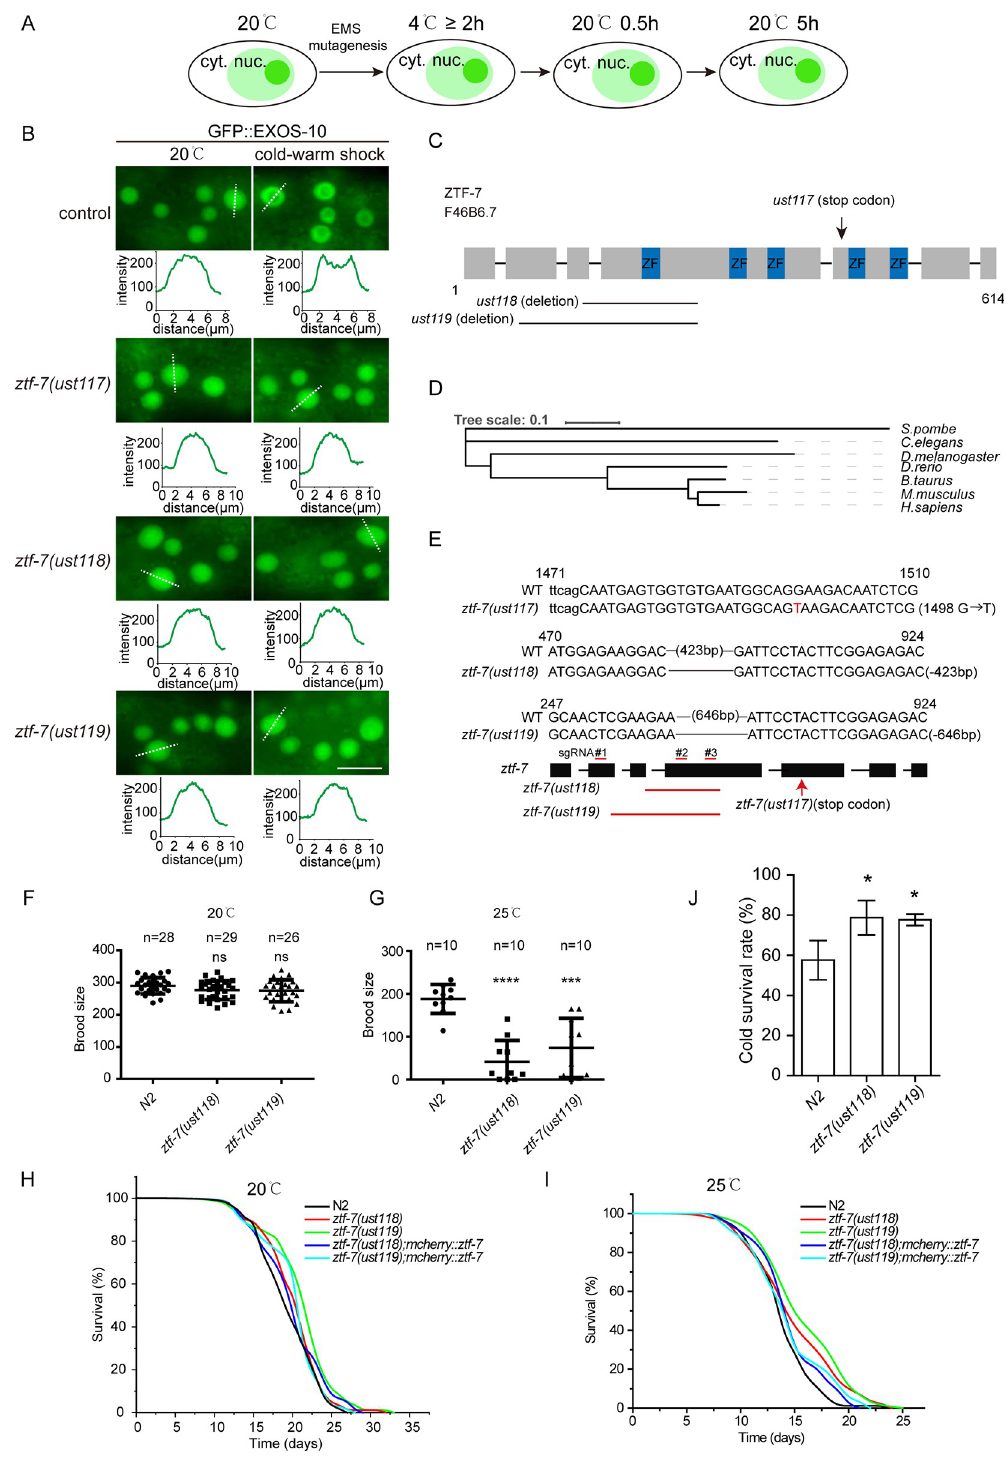
Fig 3. ZTF-7 is required for the cold-warm shock-induced nucleolar depletion of the RNA exosome complex. (A) Schematic showing forward genetic screening to search for factors required for cold-warm shock-induced EXOS-10 translocation. cyt., cytoplasm; nuc., nucleus. (B) Images of the localization of EXOS-10 at 20˚C and after cold-warm shock at 4˚C for 3 hours followed by recovery at 20˚C for 0.5 hour. Images were taken from epidermal cells. The fluorescence intensity indicated by dashed lines was measured by ImageJ. Scale bars, 10 μ m. (C) Schematic of the ZTF-7 domain structure.